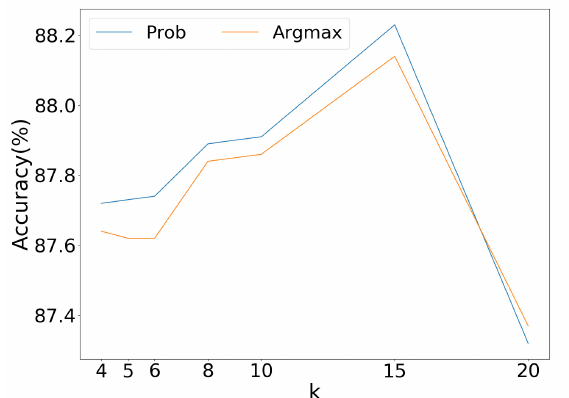
Figure 7. Ablation study on parameter selection for k-nearest neighbor and soft vs. hard decision strategy. For both Prob and Argmax methods, k = 15 is the best parameter. In most circumstances, the soft decision strategy Prob dominates hard decision strategy